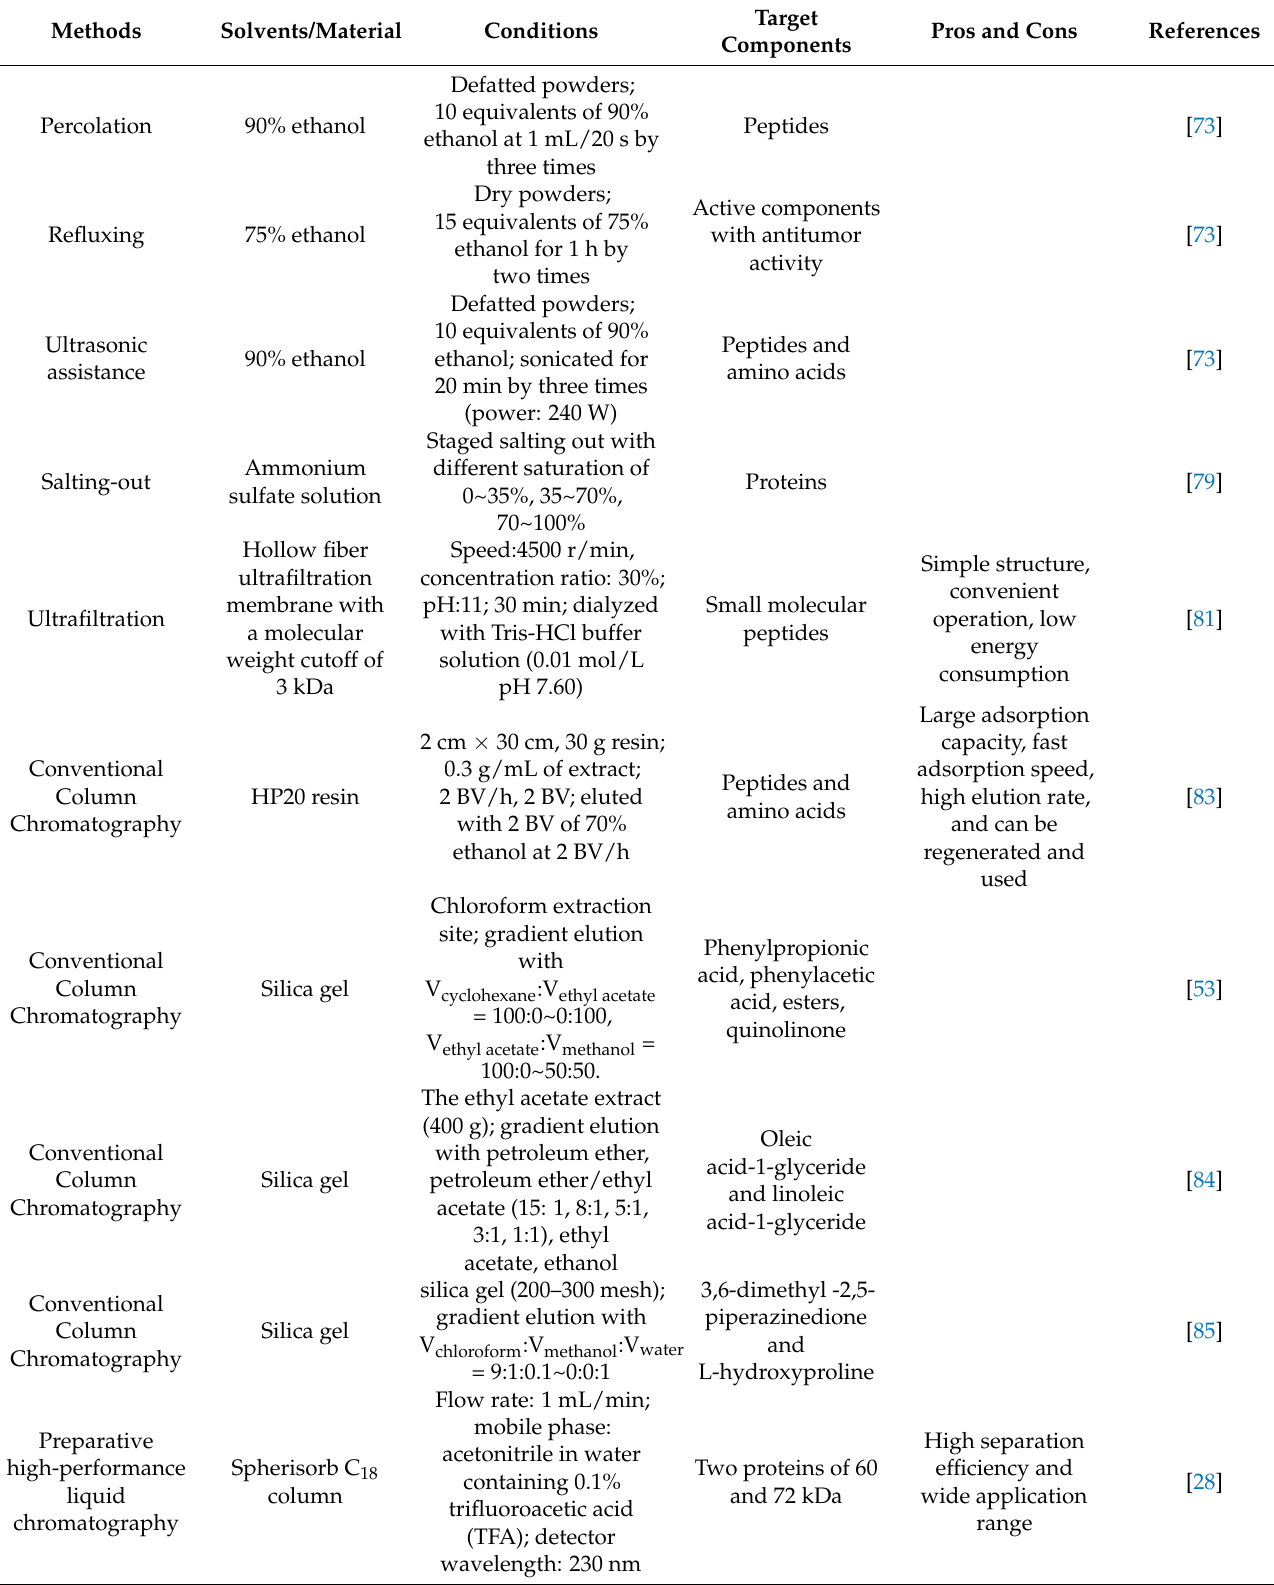
Table 2. Examples of extraction and separation methods for the family